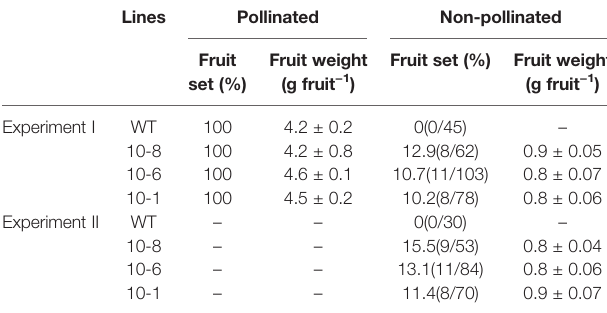
TABLE 1 | Fruit-set capacity of wild-type (WT) and PbGA20ox2 -OE lines (10-8, -6, and -1) in two independent experiments. Lines